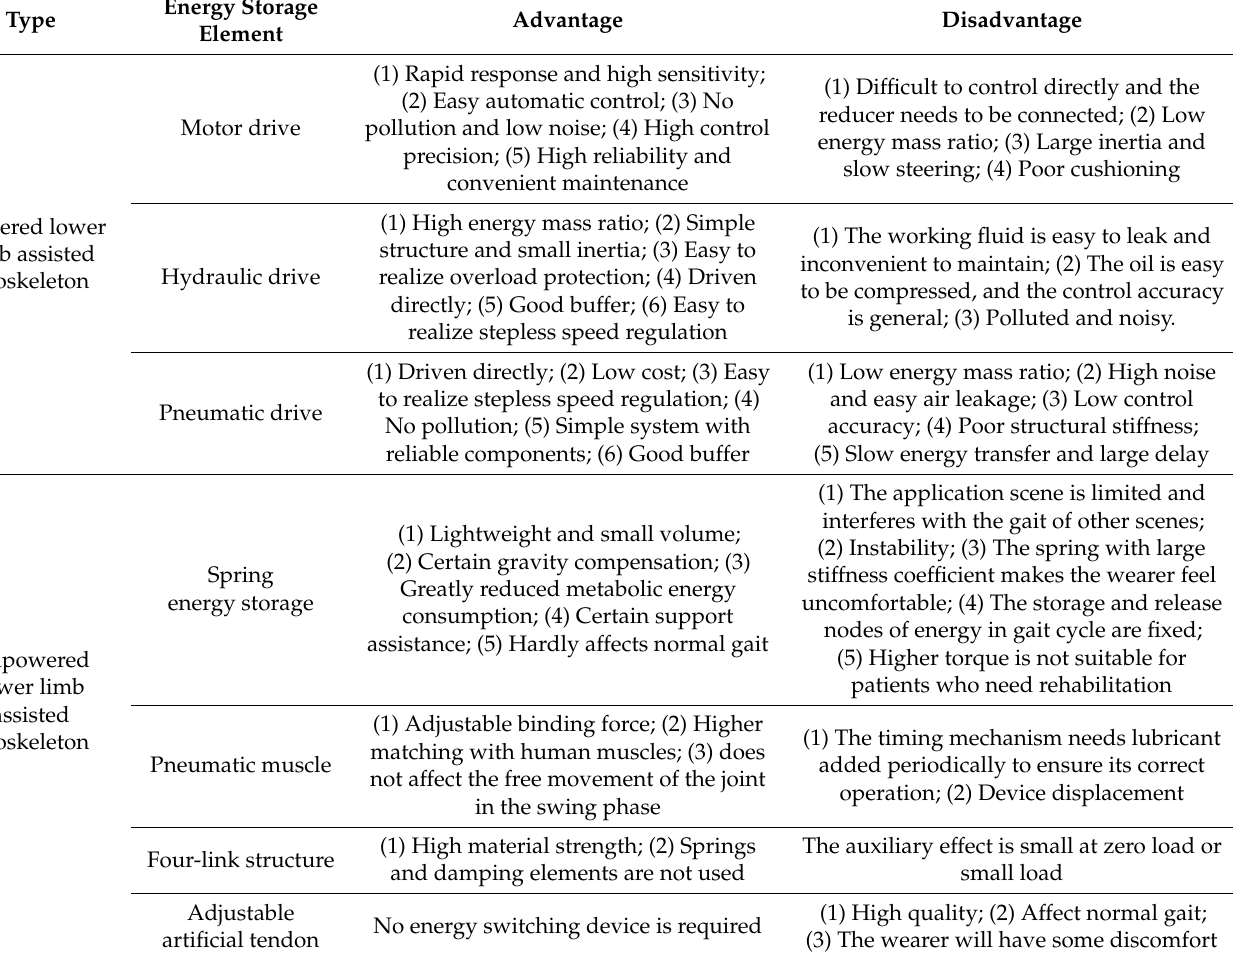
Table 8. The advantages and disadvantages of lower limb assisted